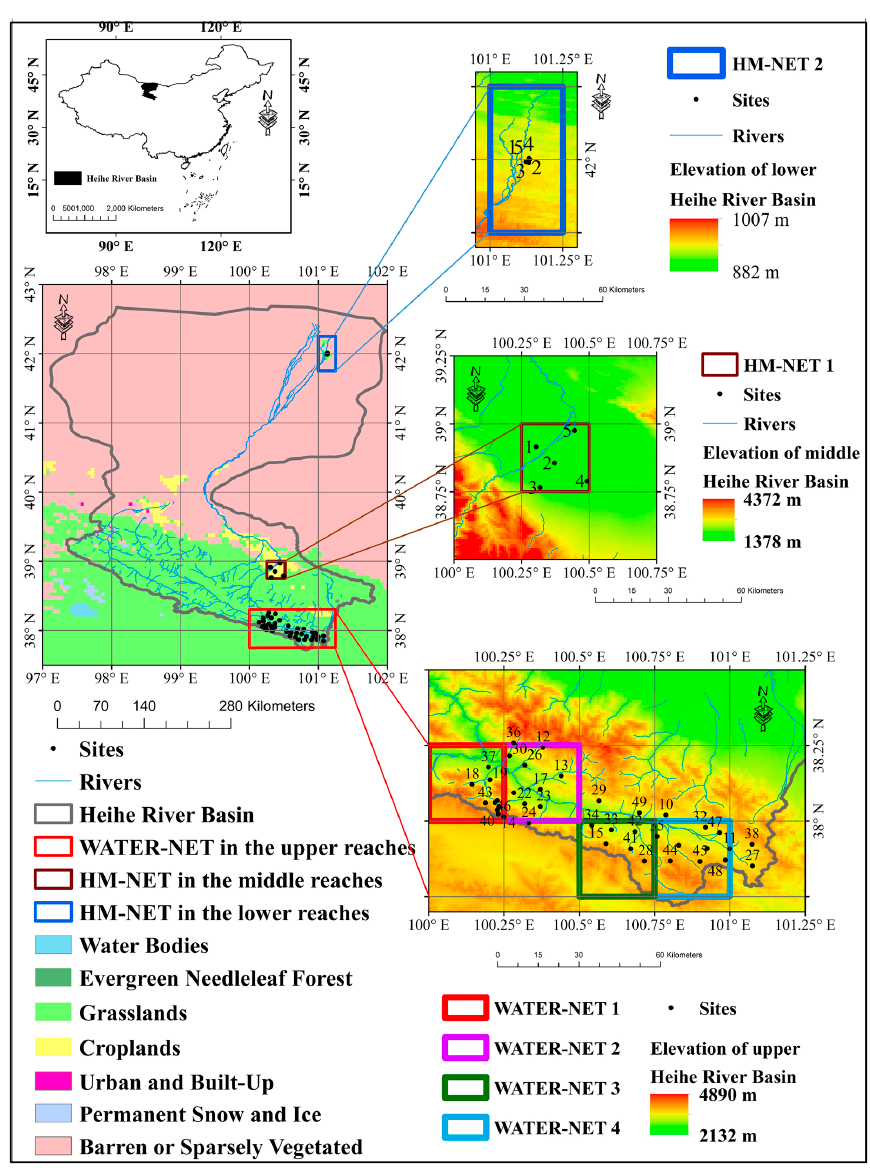
Figure 1. The locations of the sites within the Heihe River Basin (HRB) in China.